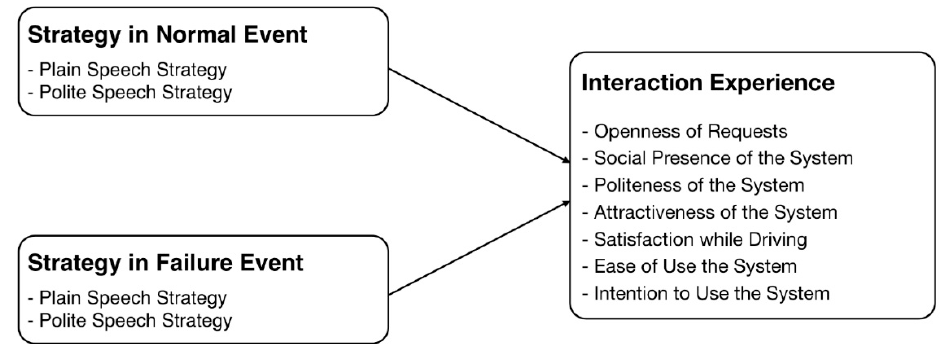
Figure 1. Research Model .